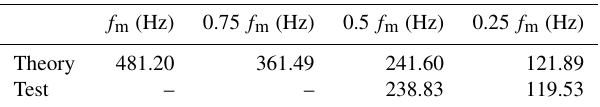
Table 5. Frequency multiplication response of the gearbox at n = 2000rpm.